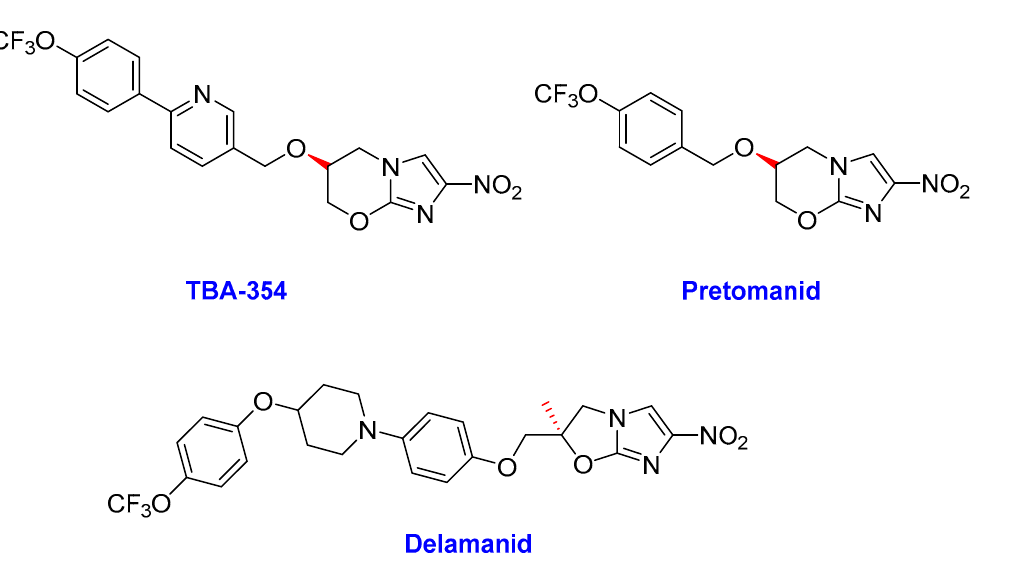
Figure 3. The chemical structure of nitroimidazoles undergoing clinical development as TB drugs.